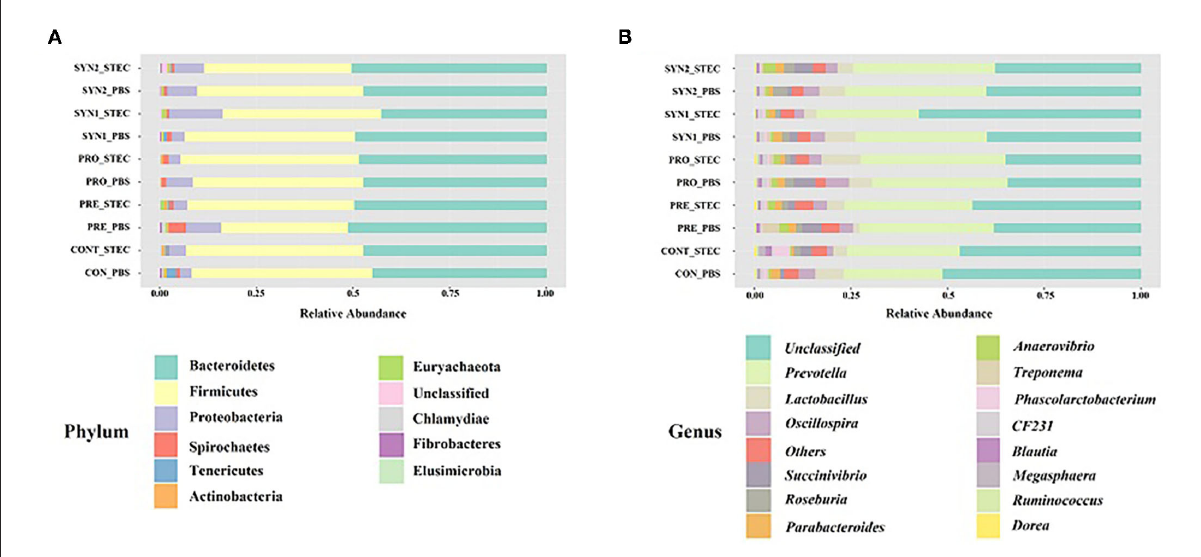
FIGURE3 Gut microbiota composition of the pig groups PRE, PRO, SYN1 and SYN2 with or without STEC challenge. Bar plots showing, the relative abundance of taxa at the phylum (A) and genus (B) levels in the different treatment groups (CONT, PRE, PRO, SYN1 and SYN2) orally challenged with STEC or